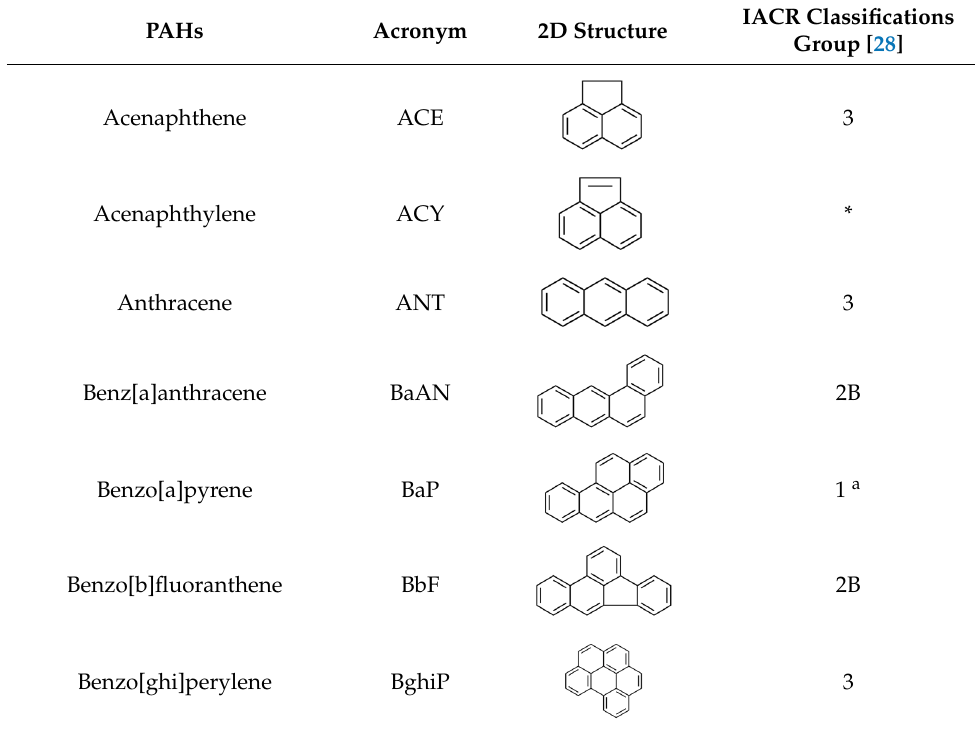
Table 1. Basic information of 16 priority pollutants of PAHs.